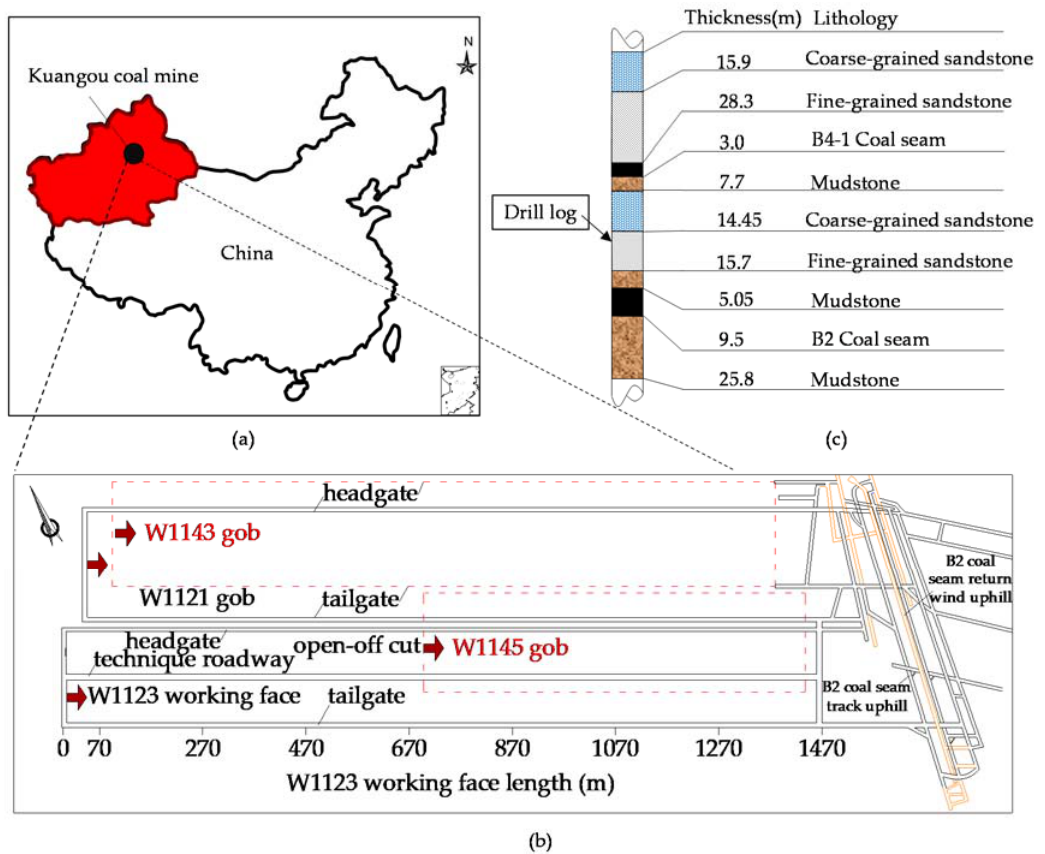
Figure 6. ( a ) Geographical overview; ( b ) W1123 working face layout; ( c ) roof and floor lithology.